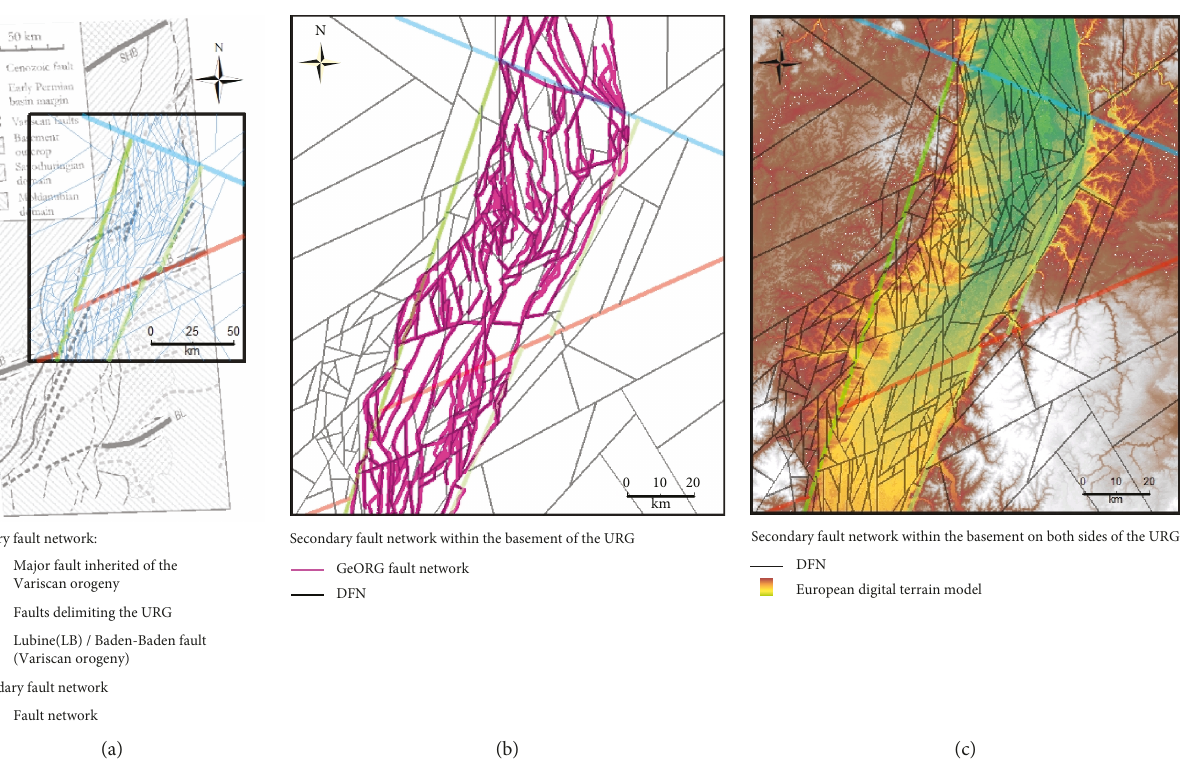
Figure 2: Illustration of the DFN building method: (a) main geological structures (example of integration of structures highlighted by [8]), (b) secondary fault network from the GeORG database within the URG [36], and (c) secondary fault network in the basement on both sides of the URG from DTM analysis